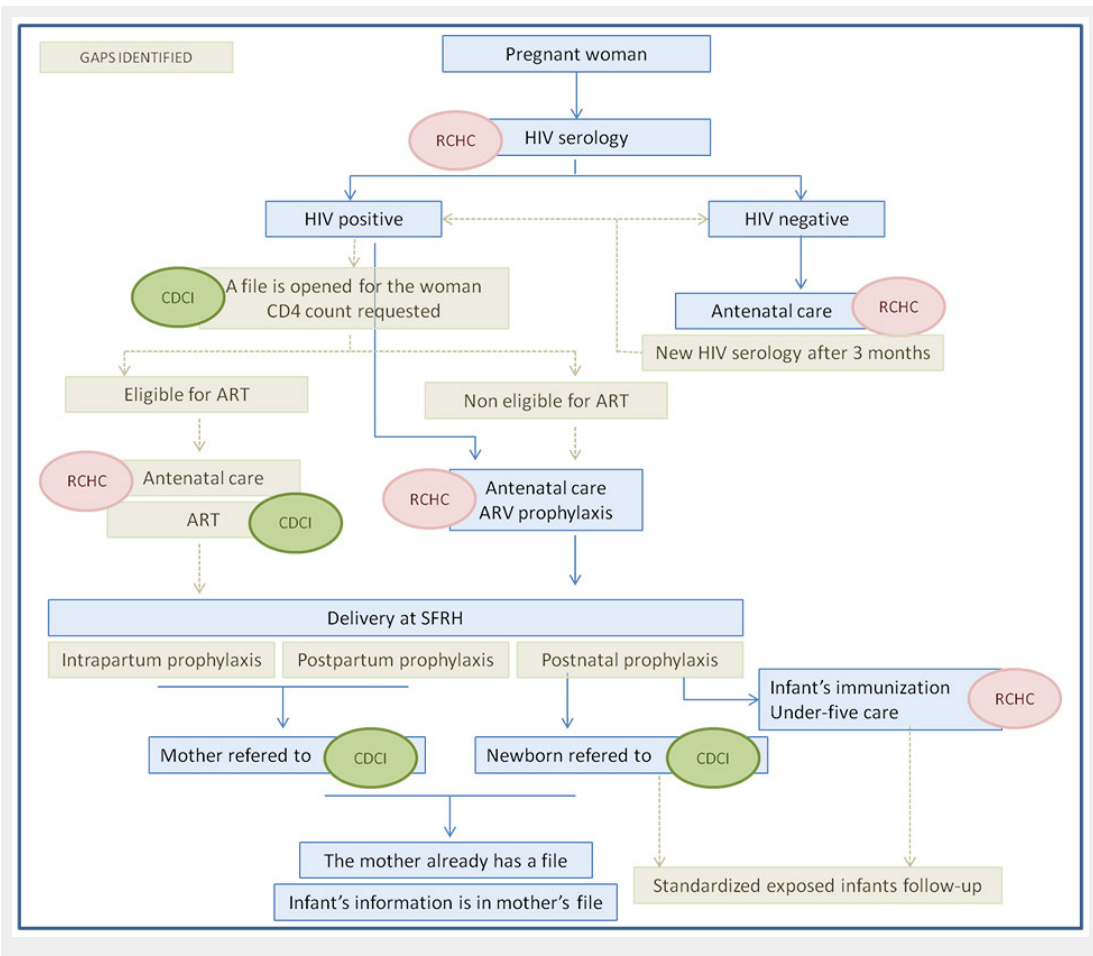
Figure 2 Main gaps identified in the care pathway for prevention of mother-to-child transmission (PMTCT) of human immunodeficiency virus (HIV) at St Francis Referral Hospital (SFRH). The gaps are coloured in brown. RCHC = Reproductive and Child Health Clinic; CDCI = Chronic Disease Clinic of Ifakara; ART = antiretroviral therapy; ARV =